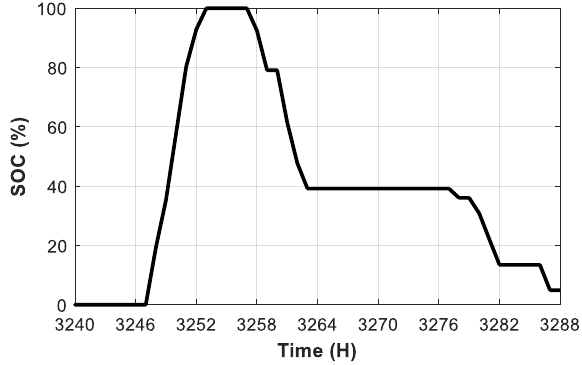
Figure 8. Microgrid operation for two days in winter using the optimal EMS Strategy.